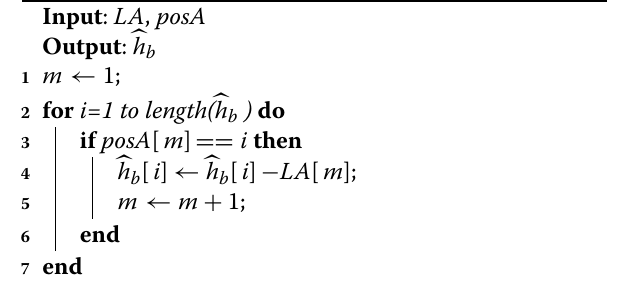
Algorithm 2: Correct the